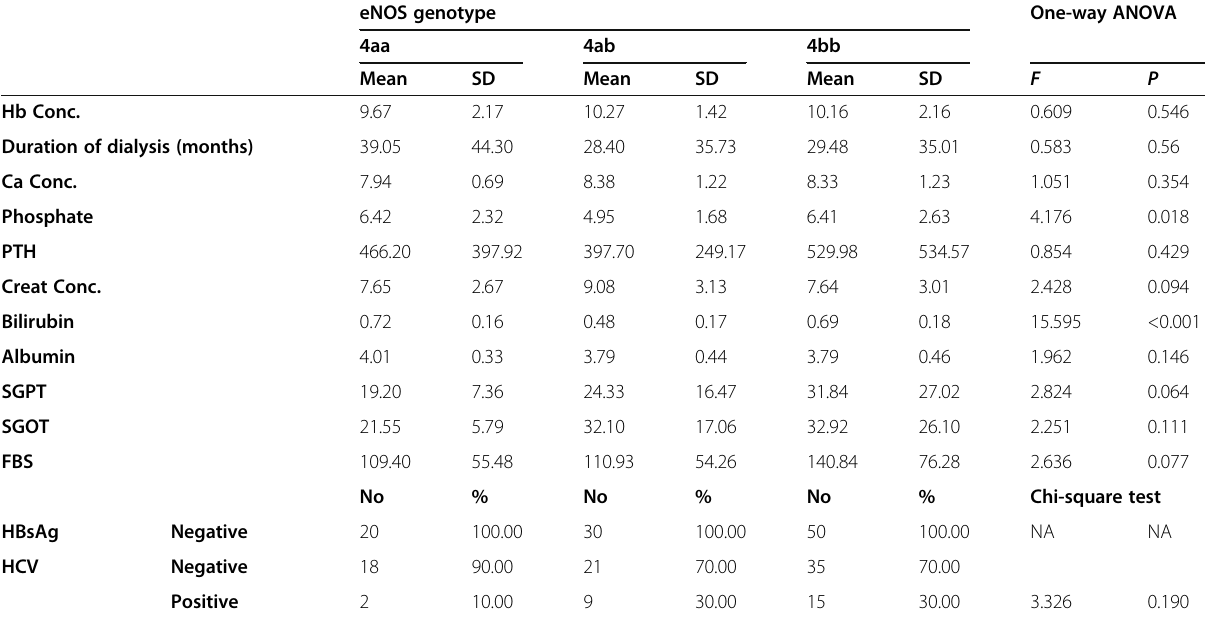
Table 5 Comparison between eNOS genotype in ESRD among clinical data eNOS genotype One-way ANOVA